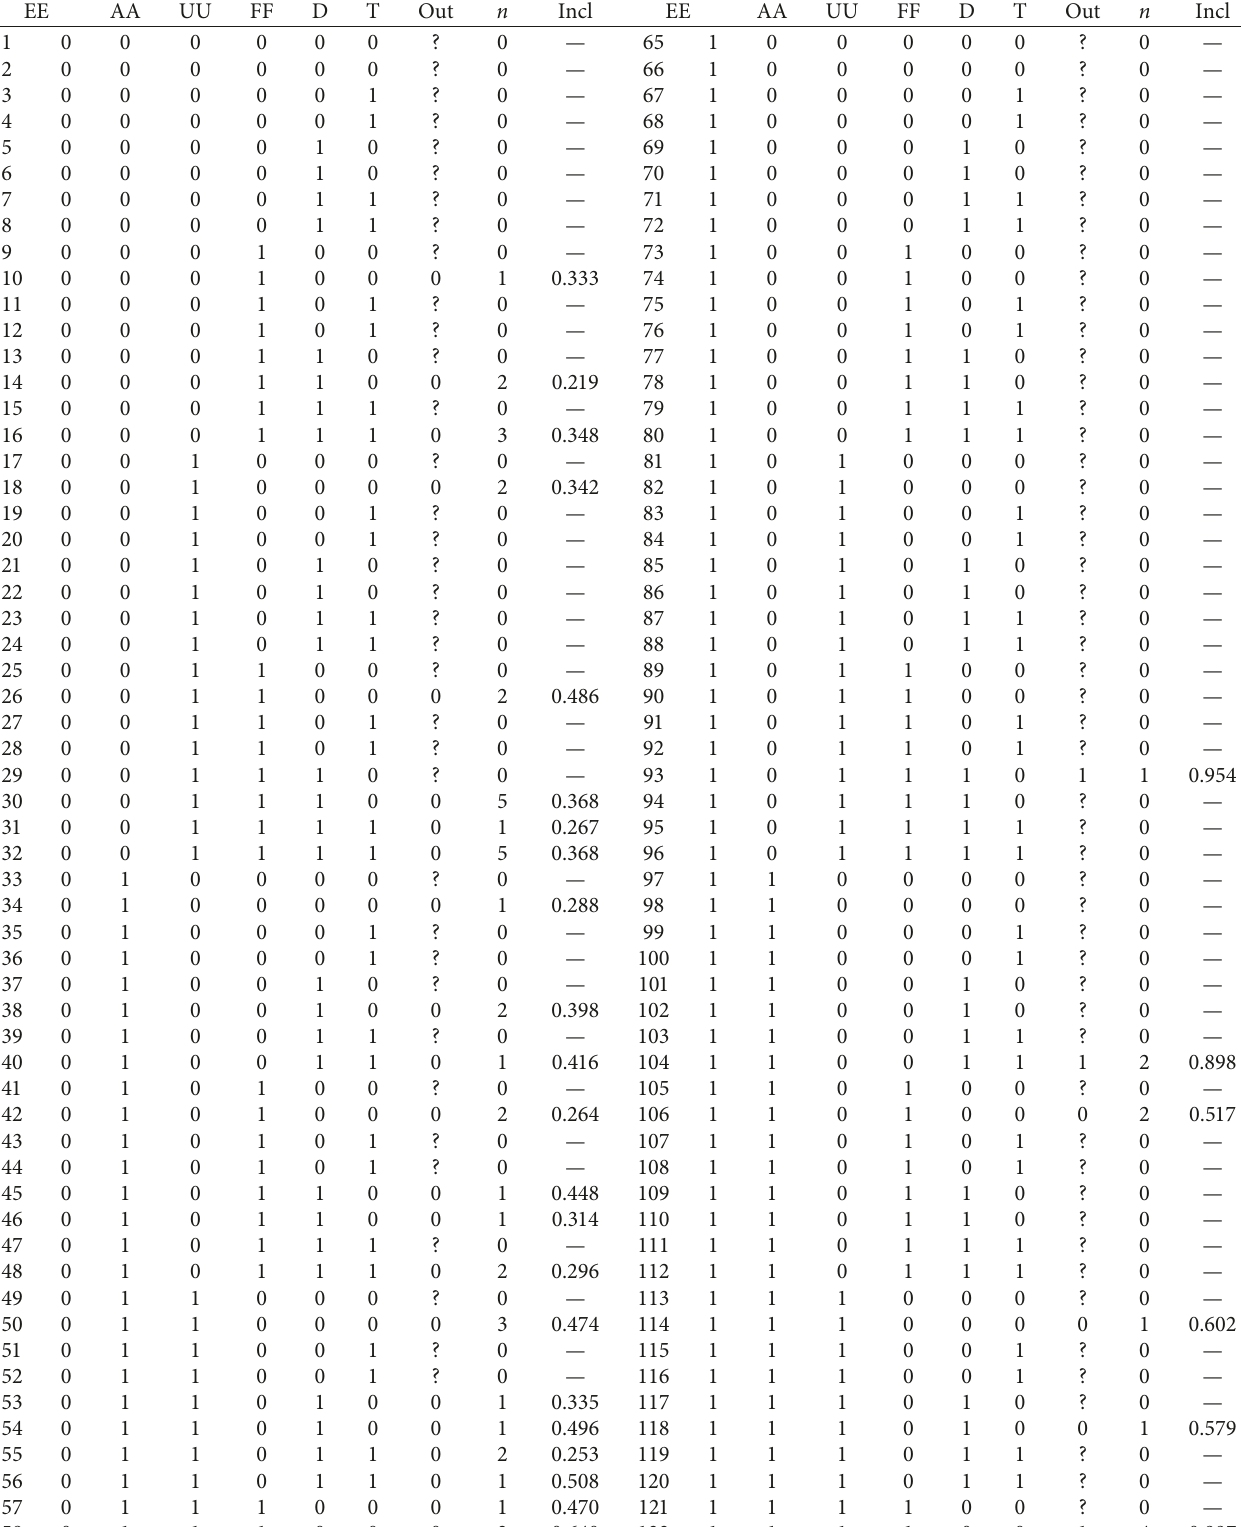
Table 5: This truth table shows the results obtained in the fuzzy sets analysis. In the table, the value 0 means no involvement of that variable in the explanation of the long-term sustainability of the company. On the contrary, the value 1 means relevance. And ? symbol means that nothing can be